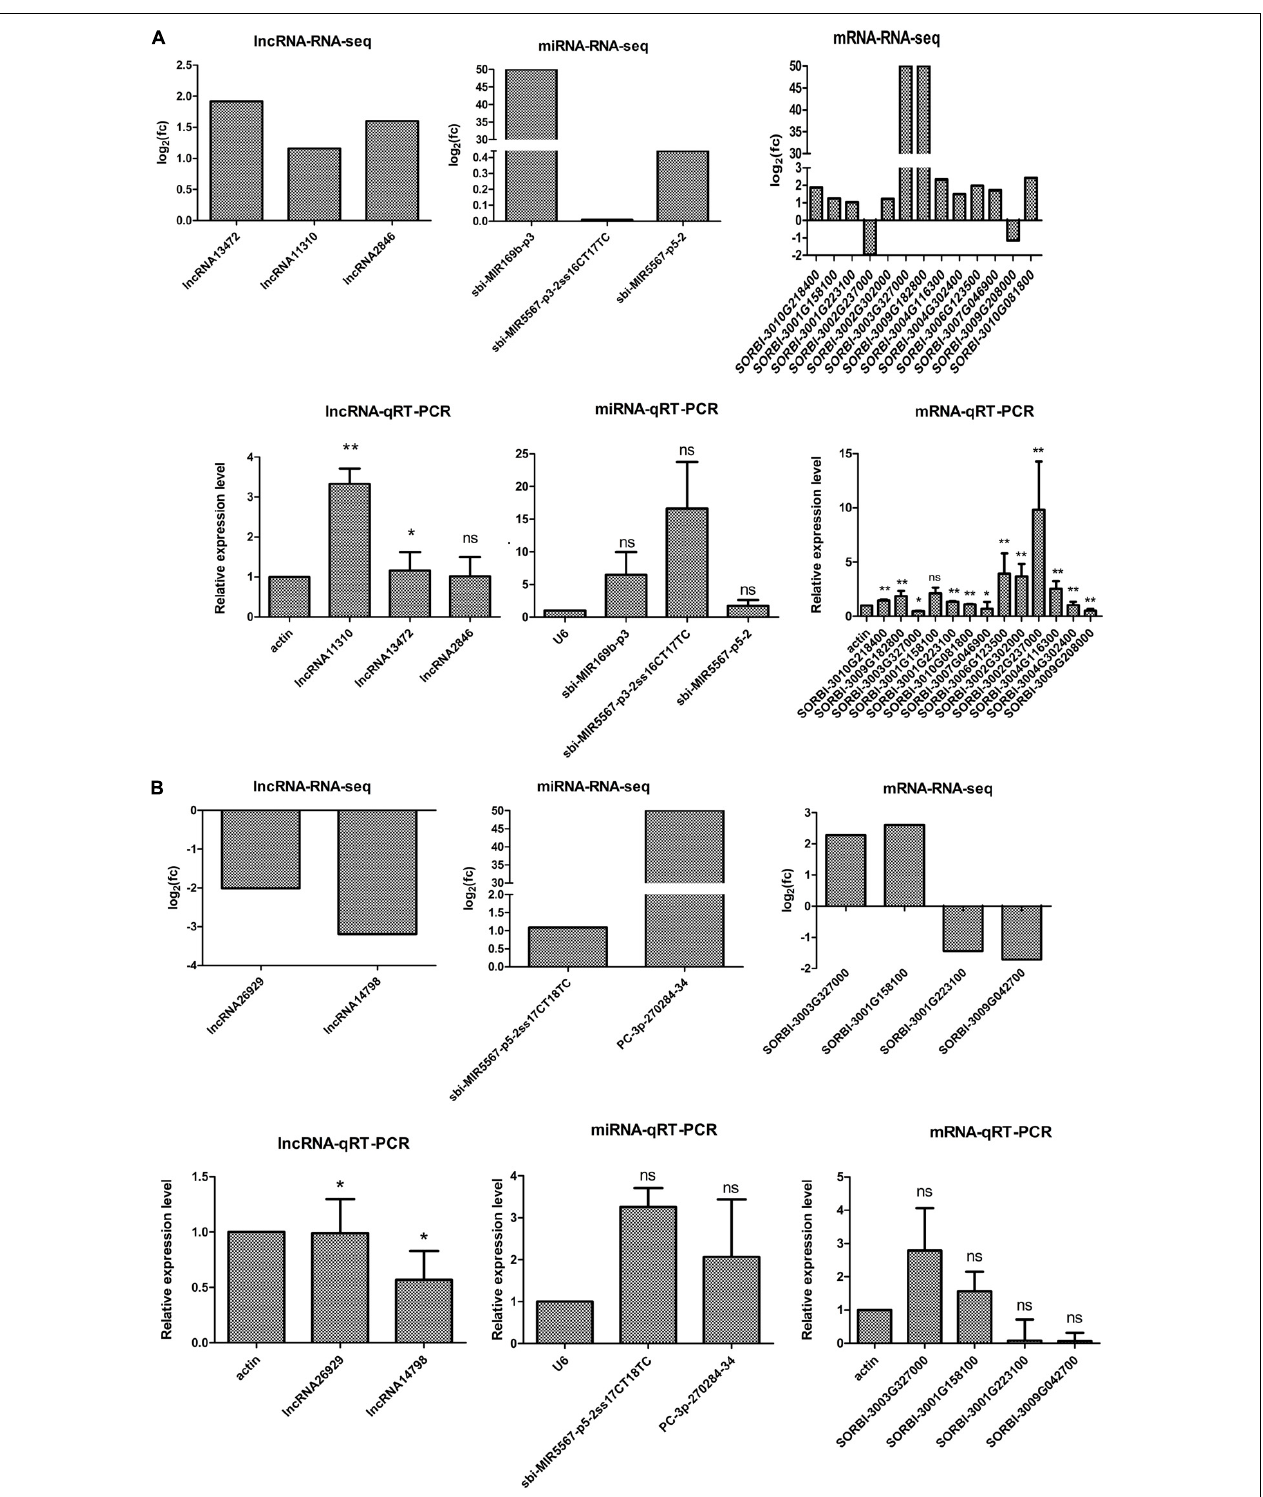
FIGURE 6 | Quantitative RT-PCR analysis and RNA-seq results of ceRNA regulatory networks in M-81E (A) and Roma (B) . Three biological replicates were prepared for each of these samples. Actin is the endogenous reference gene for lncRNAs and mRNAs, and U6 is the endogenous reference gene for miRNAs. The y-axis shows the relative expression levels analyzed by qRT-PCR. Based on three biological replicates, each repeated three times, the standard deviation of the relative expression levels ( n = 3) is indicated by error bars. Significant differences between each RNA and internal reference were also assessed separately ( p < 0.05). ** indicates p < 0.01, * indicates p < 0.05, and ns indicates p >